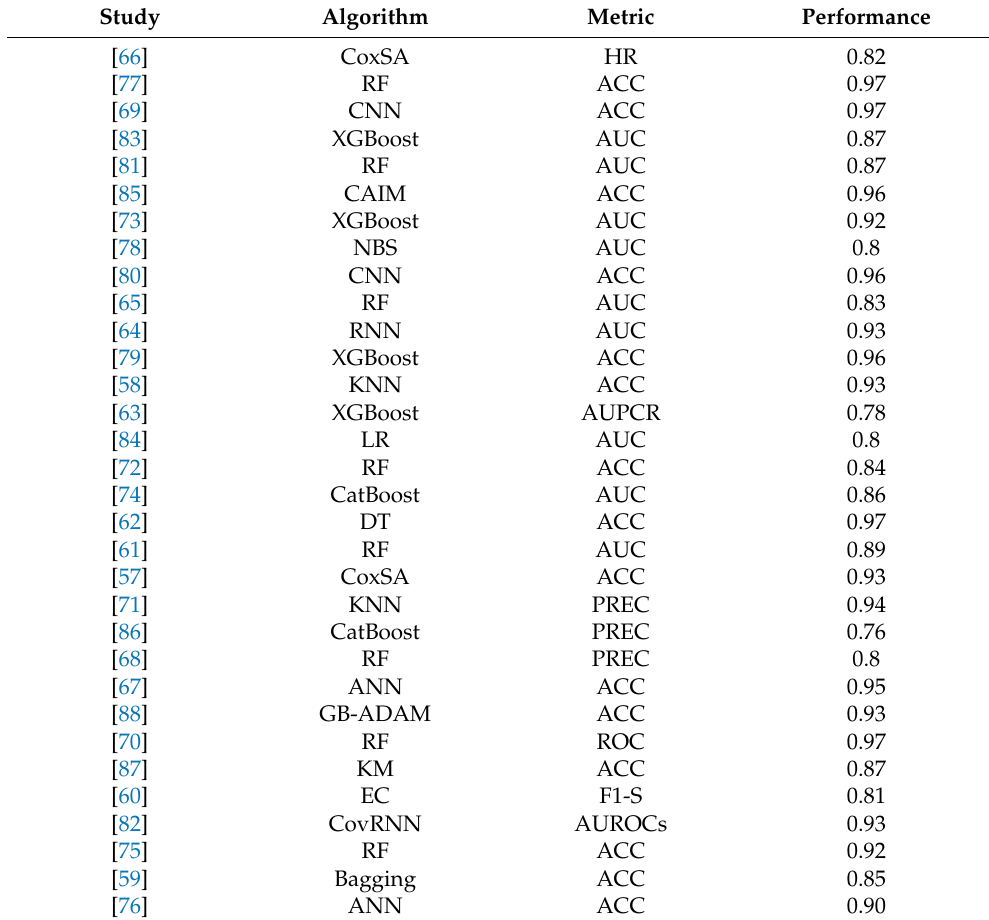
Table 8. Metric average performance with the best accuracy of the algorithms found in the